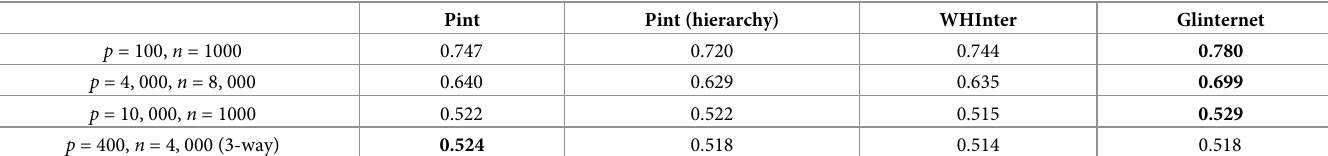
Table 1. Overall AUROC for simulated data sets.